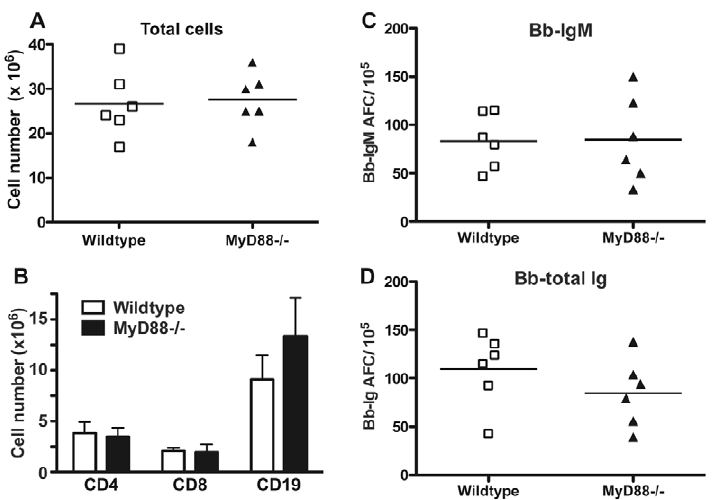
Figure 7. Lymphadenopathy and lymph node B cell activation are independent of MyD88-signaling. Control C57BL/6 (wildtype) and congenic MyD88 2 / 2 mice (n=6 per group) were infected with host-adapted B. burgdorferi for 10 days. Lymph nodes were harvested and compared for ( A ) total cellularity and ( B ) numbers of CD4, CD8 and CD19 as assessed by flow cytometry. ELISPOT analysis was conducted to determine numbers of ( C ) borrelia-specific IgM or ( D ) all Ig-isotype secreting borrelia-specific cells. For scatter plots, each symbol represents the result from an individual animal. Lines indicate mean of the group. Bar chart shows the mean values 6 SD. Results are pooled from two independent experiments. Statistical analysis for (A) (C) (D) was conducted by Student’s t test and (B) by two-way ANOVA. None of the data showed significant differences between control and MyD88 2 / 2 mice.